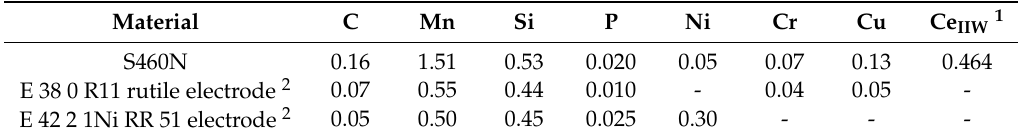
Table 1. The chemical composition of used materials wt %.